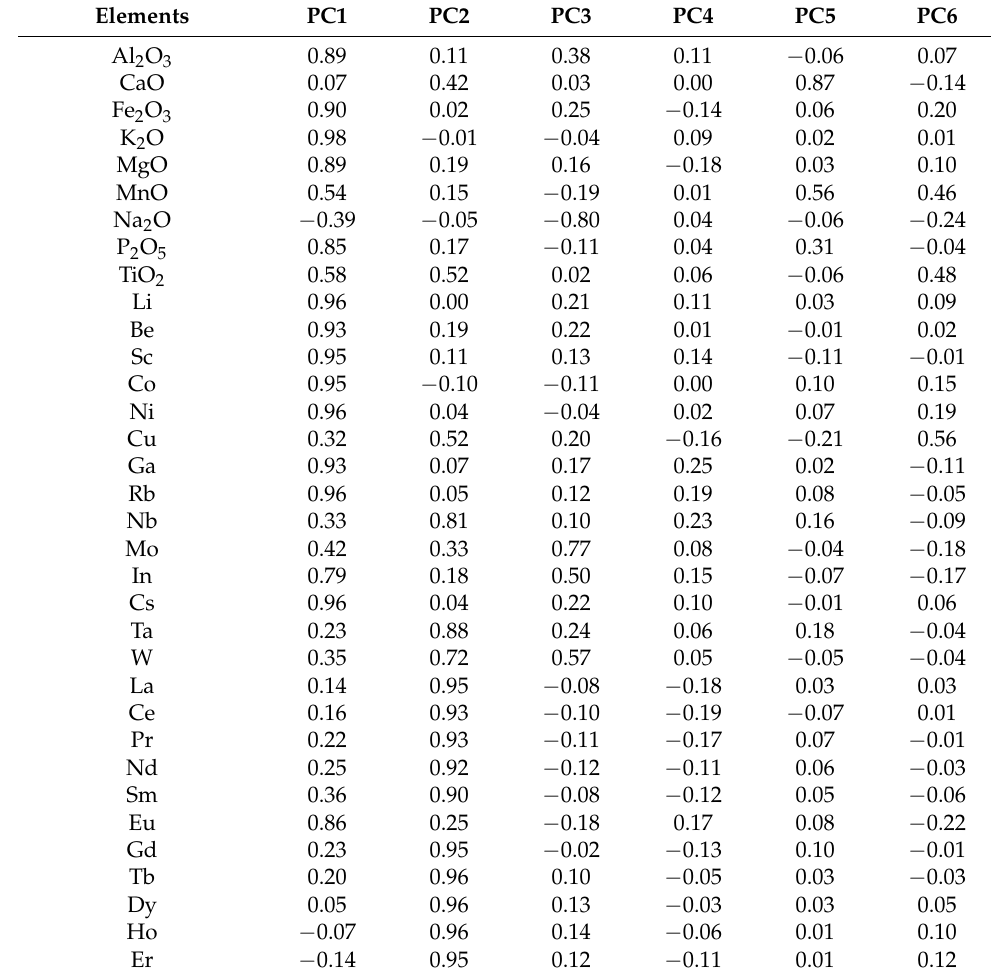
Table 2. Principal component analysis results for grain size compositions (sand, silt, and clay) and major and trace elemental compositions (including rare earth elements) of the surface sediment samples from the Malay Peninsula and the adjacent Sunda